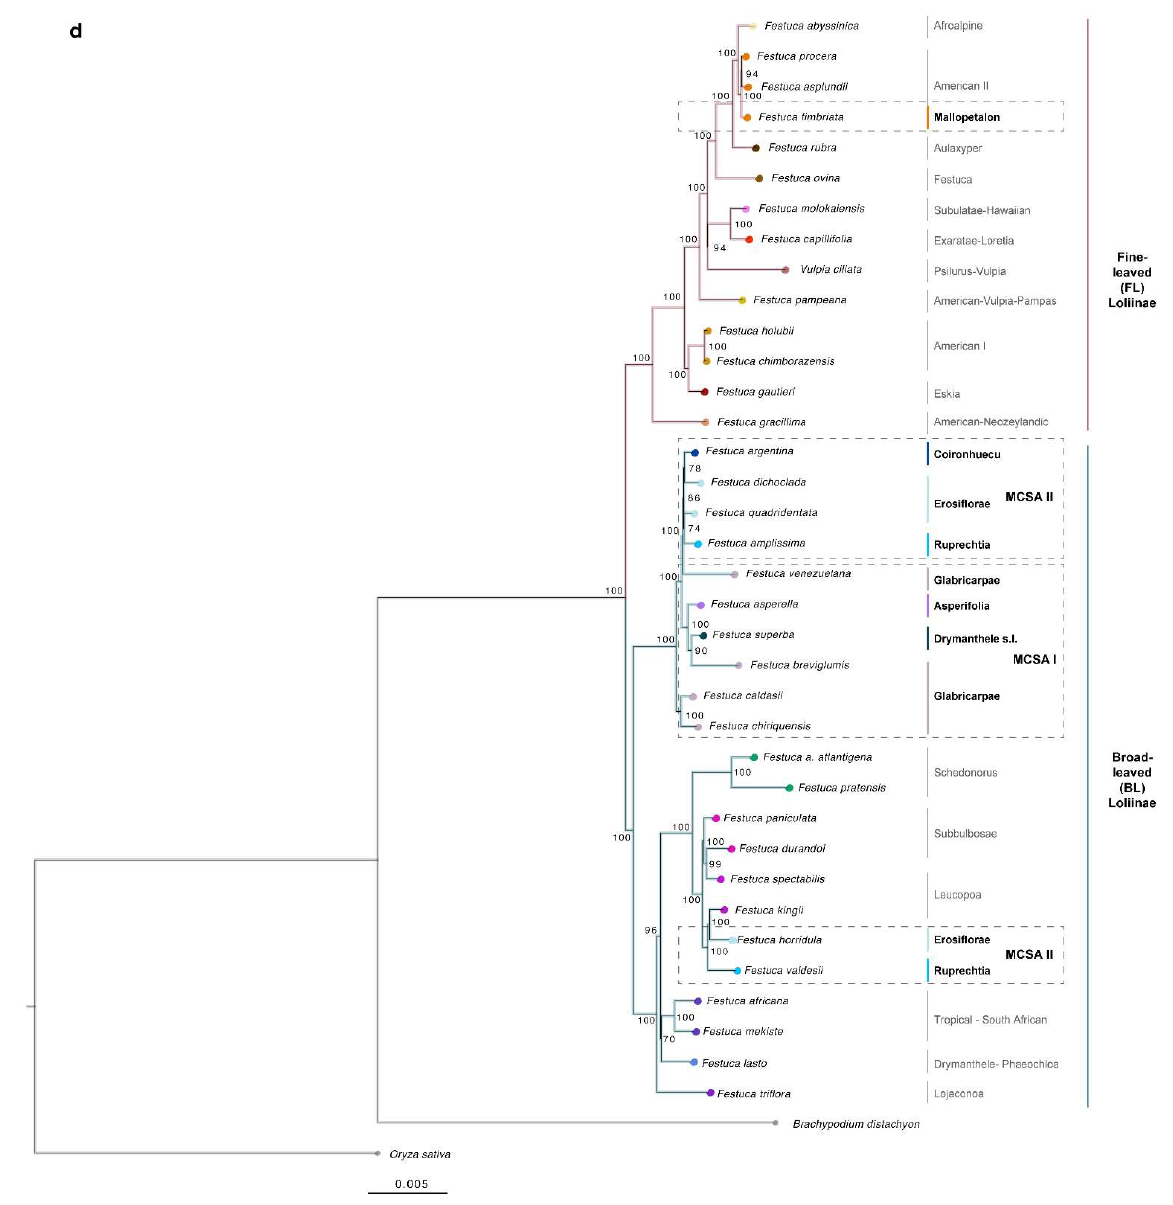
Figure 2. Maximum likelihood phylogenomic trees of the Mesoamerican and South American broad-leaved Festuca taxa studied and other representative species of the broad-leaved (BL) and fine-leaved (FL) Loliinae lineages. ( a ) Nuclear rDNA 35S cistron tree. ( b ) Nuclear rDNA (45S) IGS tree. ( c ) Nuclear rDNA 5S tree. ( d ) Plastome tree. Mexico–Central–South American (MCSAI, MCSAII) and Mallopetalon groups are indicated by discontinuous-line rectangles. Ultrafast bootstrap support values are indicated on branches. Oryza sativa and Brachypodium distachyon outgroups were used to root the trees except for the IGS and 5S trees that were rooted at midpoint. Color codes of Loliinae lineages are indicated in the chart of Figure 2a. Scale bars: number of mutations per site.